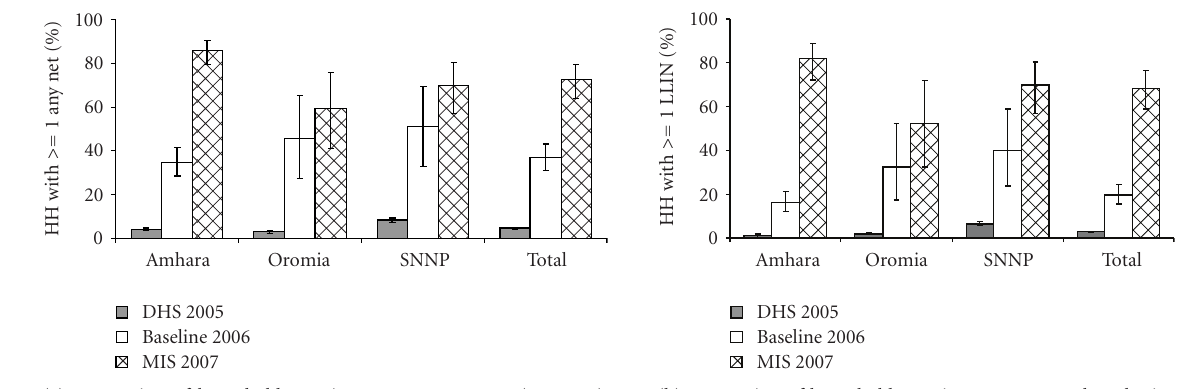
not LLIN, as it did not make this distinction “Total” refers to the weighted average percentage for the three regional states Figure 3: Proportion of households owning one or more nets.